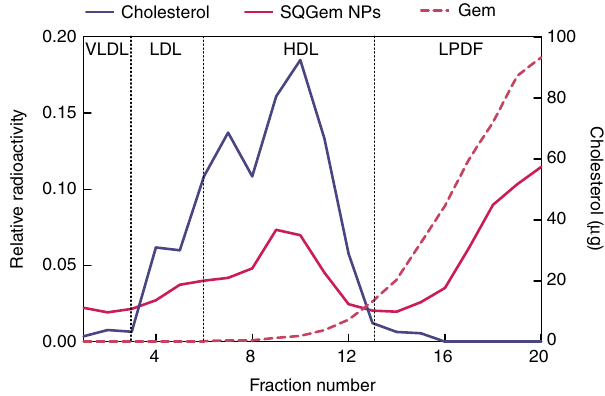
Figure 4 | 3 H-SQGem and 3 H-Gem plasmatic distribution in vivo . Radioactivity (magenta lines) and cholesterol (blue line) distribution among the collected fractions of plasma obtained from rats treated with 3 H-SQGem (solid magenta line) or free 3 H-Gem (dashed magenta line), 5min post administration. Results are expressed as relative radioactivity (mean values) compared to total